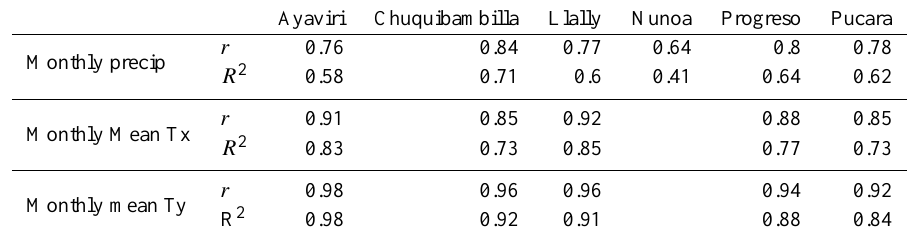
Table 5. Correlation coefficient between the stations used to reconstruct Santa Teresa